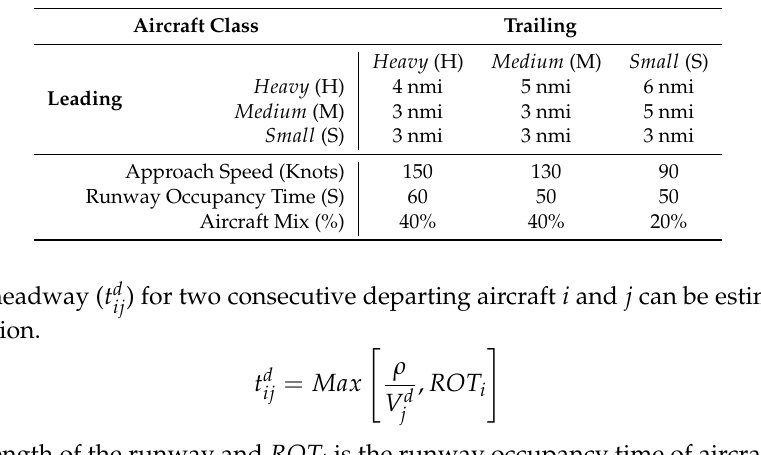
Table 2. Separation, approach speed and traffic mix distribution of different classes of